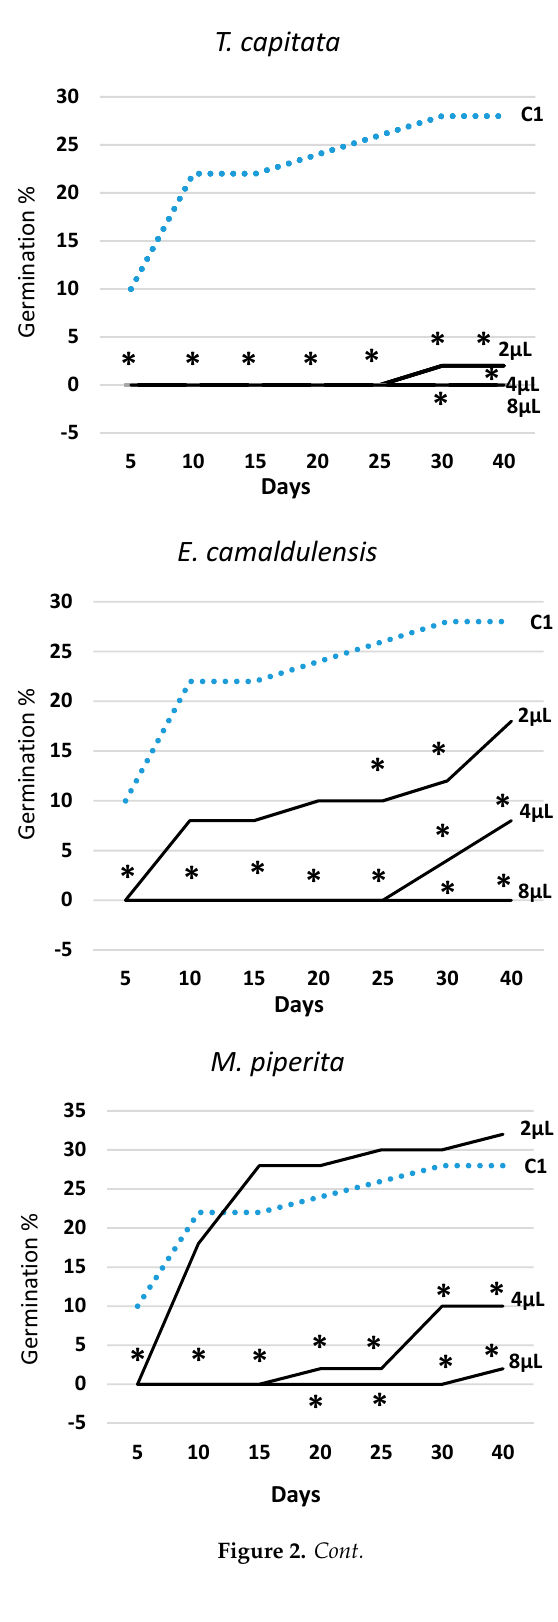
Figure 2. Figure 2. Trend over time of percent seed germination (cumulated values) in Erigeron bonariensis exposed to four EOs at three doses (2 µL, 4 µL, 8 µL). For each observation day, values marked with * are significantly different from the water control (C1; dotted line) at P ≤ 0.05 (Dunnett’s test).